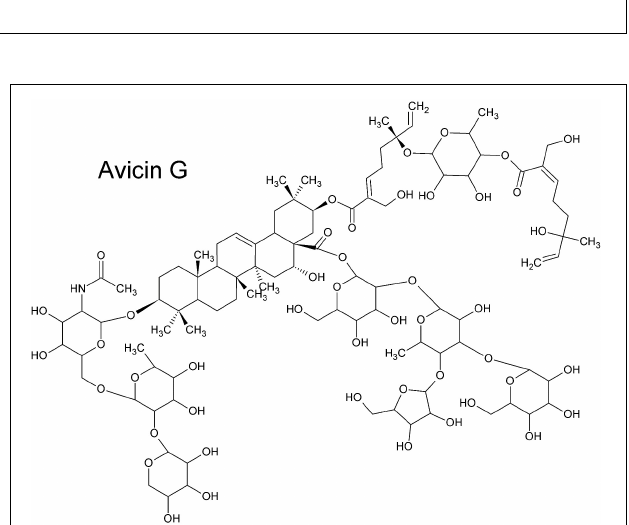
FIGURE 5 | Simple examples for the calculation of polar surface area.